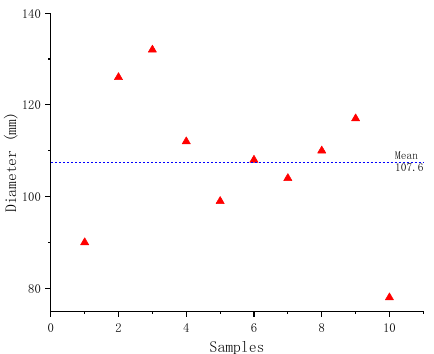
Figure 11. The diameter of the randomly selected grape clusters.